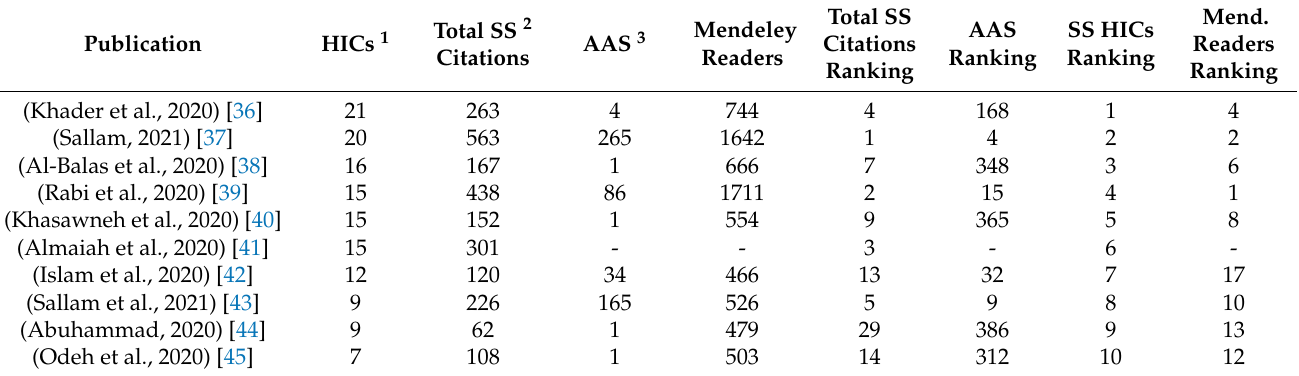
Figure 3. The lack of correlation between Semantic Scholar Highly Influential Citations and the Alt- metric Attention Scores. Table 2. Features of the top 10 included publications in descending order based on SS